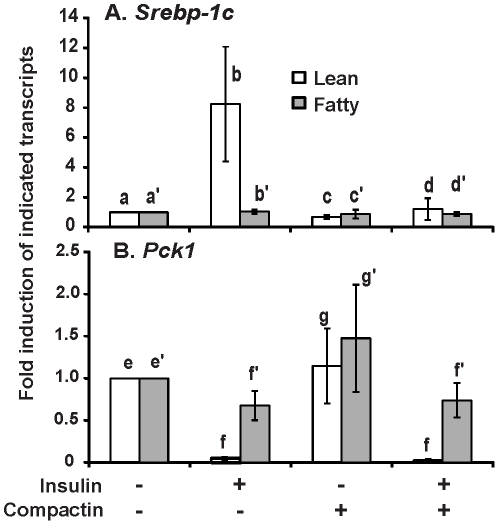
The effects of compactin and insulin on the mRNA levels of Srebp-1c (A) and Pck1 (B) in hepatocytes from ad libitum Zucker lean and fatty rats.Primary hepatocytes after pretreatment as described in Materials and Methods were incubated in medium A without or with 50 µM compactin in the absence or presence of 1 nM insulin for 6 hours. Total RNA was extracted and subjected to real-time PCR analysis. The expression level of the indicated transcripts in the control hepatocytes (lean or fatty) was arbitrarily assigned a value of one for its corresponding cell type. Results were plotted as fold induction and presented as means ± SD of four independent hepatocyte isolations for both lean and fatty rats (n = 4 for hepatocyte isolations; for Srebp-1c, b>a>c, b>d and b>b′, using one-way ANOVA; for Pck1, e/g>f, and f′>f, using one-way ANOVA; all P<0.05).